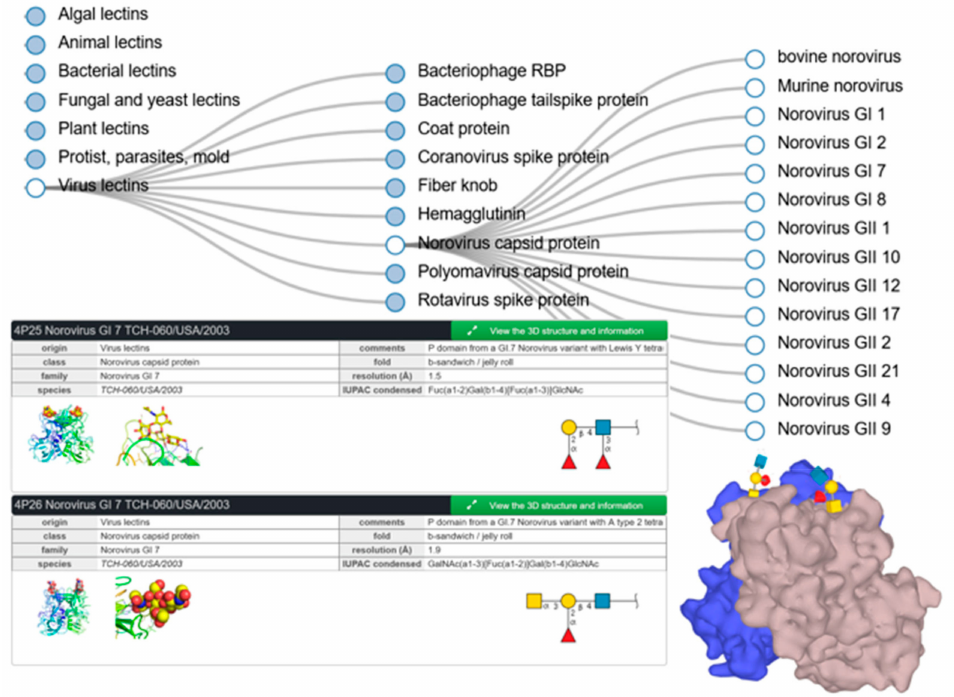
Figure 5. Partial result of UniLectin3D search for Norovirus, with selected examples of entries of GI-7